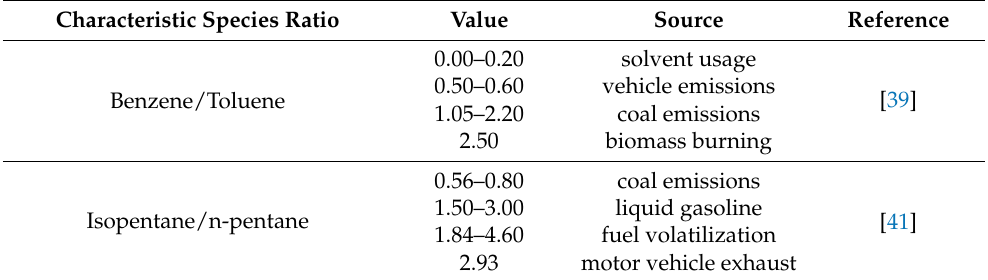
Table 3. Ratio data of benzene to toluene and isopentane to n-pentane. Characteristic Species